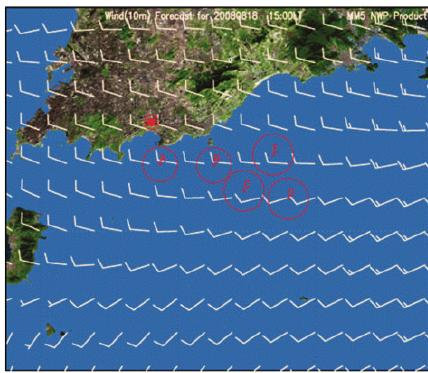
Figure 8: Distribution of wind vector at the height of 10m at